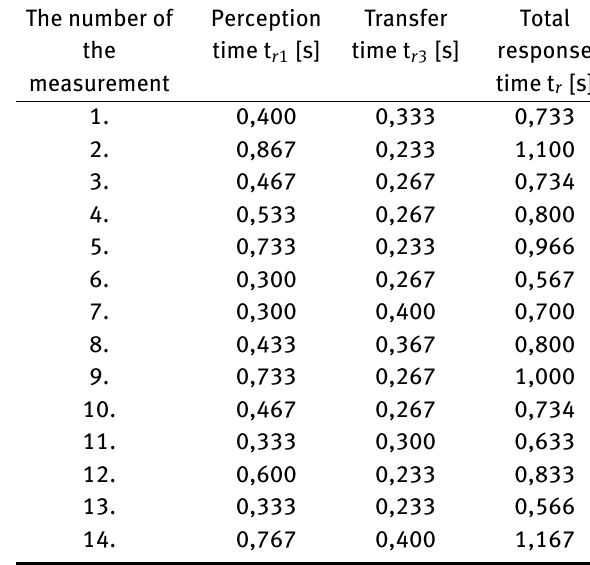
Table 9: Summary of the results of driver D.